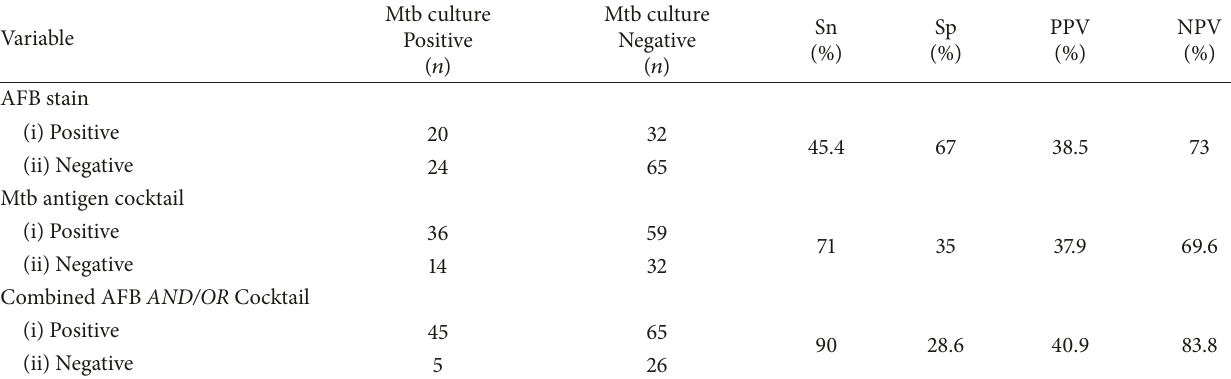
Table 2: Sensitivity – specificity for AFB stain and Urinary Mtb antigens cocktail among Pulmonary Tuberculosis Patient, against Mycobacterial Culture.